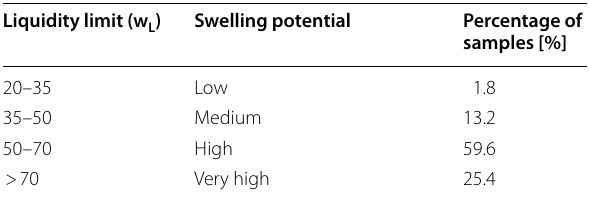
Table 7 Liquidity limit and swelling potential